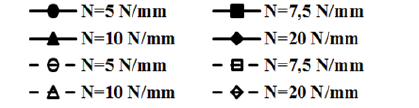
Table 1. Guide resource L 1( М ) for a bushing made of Moglice